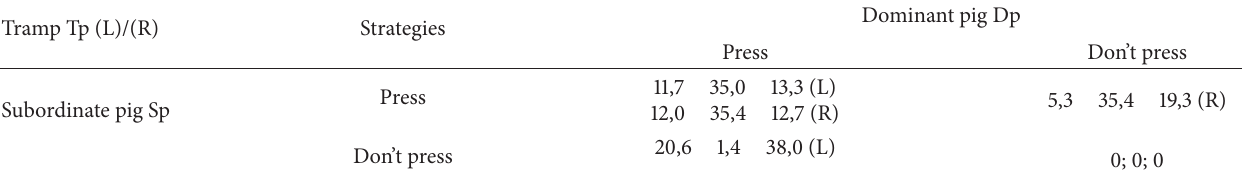
Table 5: Rational Pigs Extended—payoffs according to the simulation with defined parameters (Table